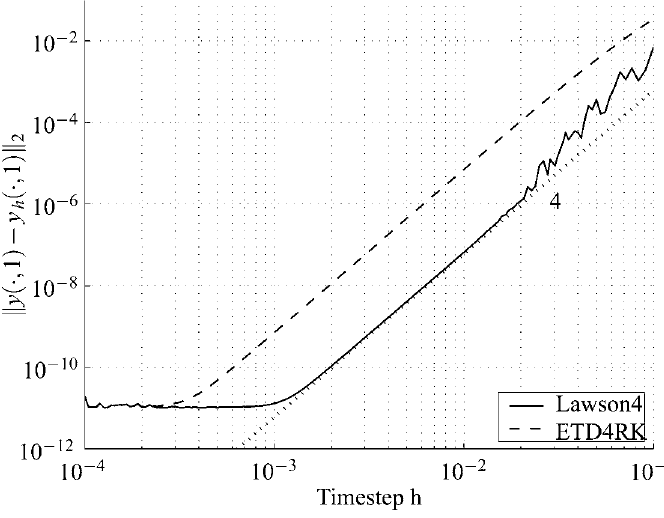
Figure 1. A global order test. Both exponential integrators in this study perform as order 4 integrators. The dotted line is only an indicator line showing how order 4 looks